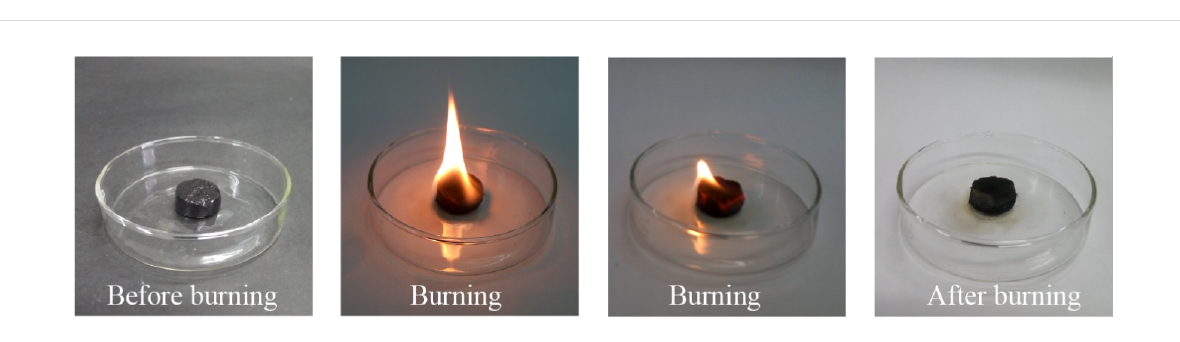
Figure 9: Photographs showing the recycling process of CNF/PVA/GO carbon aerogels via